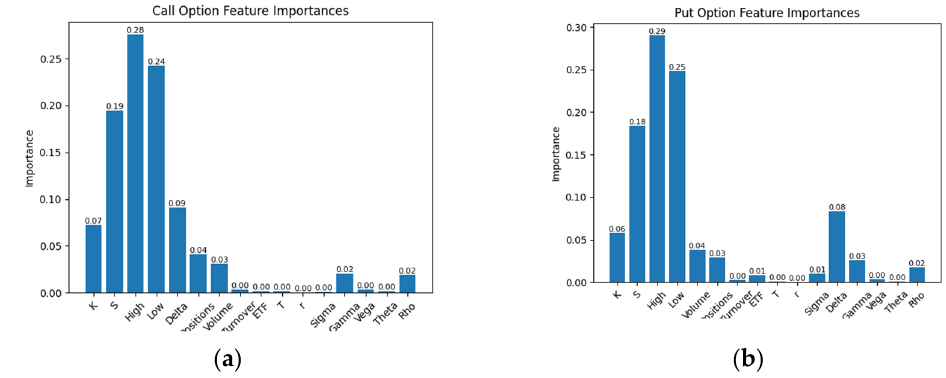
Figure 6. Feature importance ranking ( a ) of call option; ( b ) of put option.